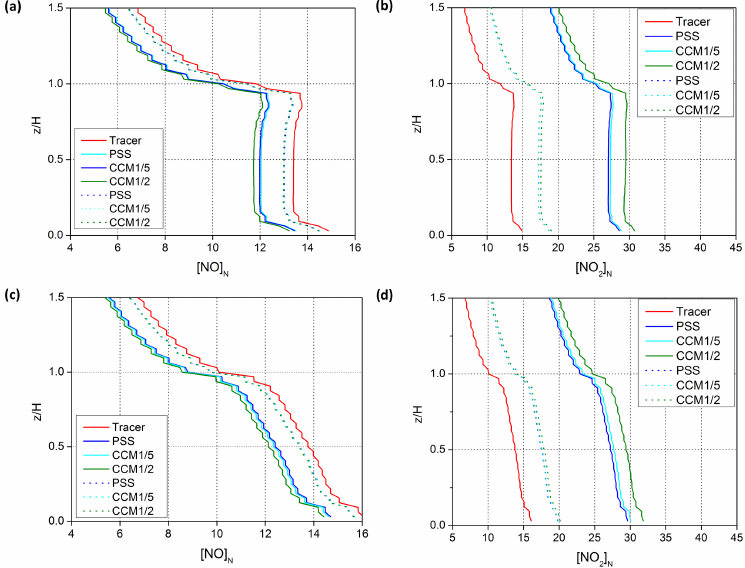
Figure 5. Vertical profiles of horizontal spatial average of [NO] N and [NO 2 ] N for all chemical scenarios in case 2 (solid line) and case 4 (dotted line) in both geometries: 2-D (a, b) and 3-D (c, d)